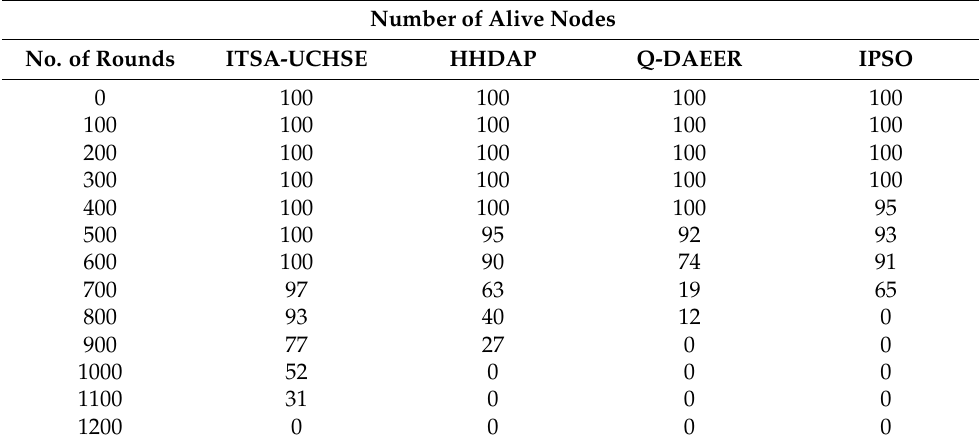
Table 2. NOAN analysis of ITSA-UCHSE system with current methods under different